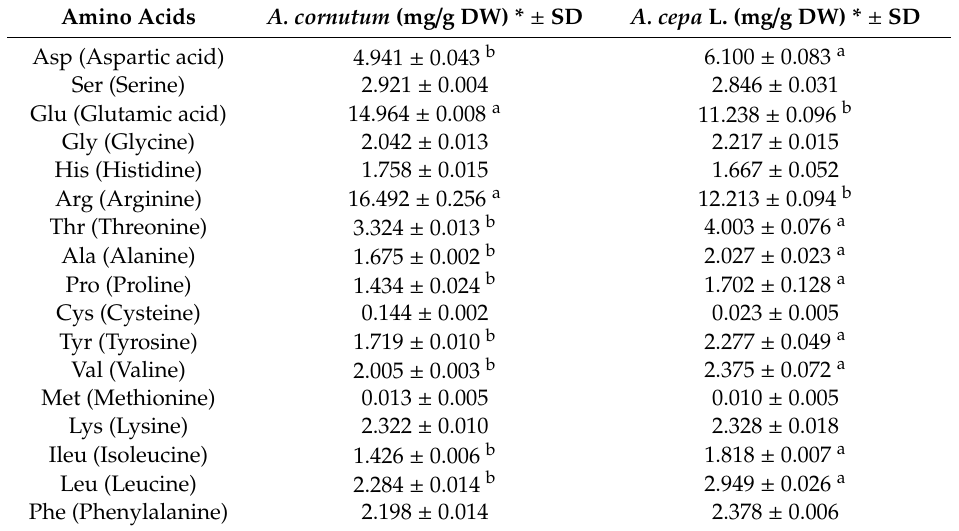
Table 2. Amino acid composition of triploid hybrid onion A. cornutum and common onion A. cepa